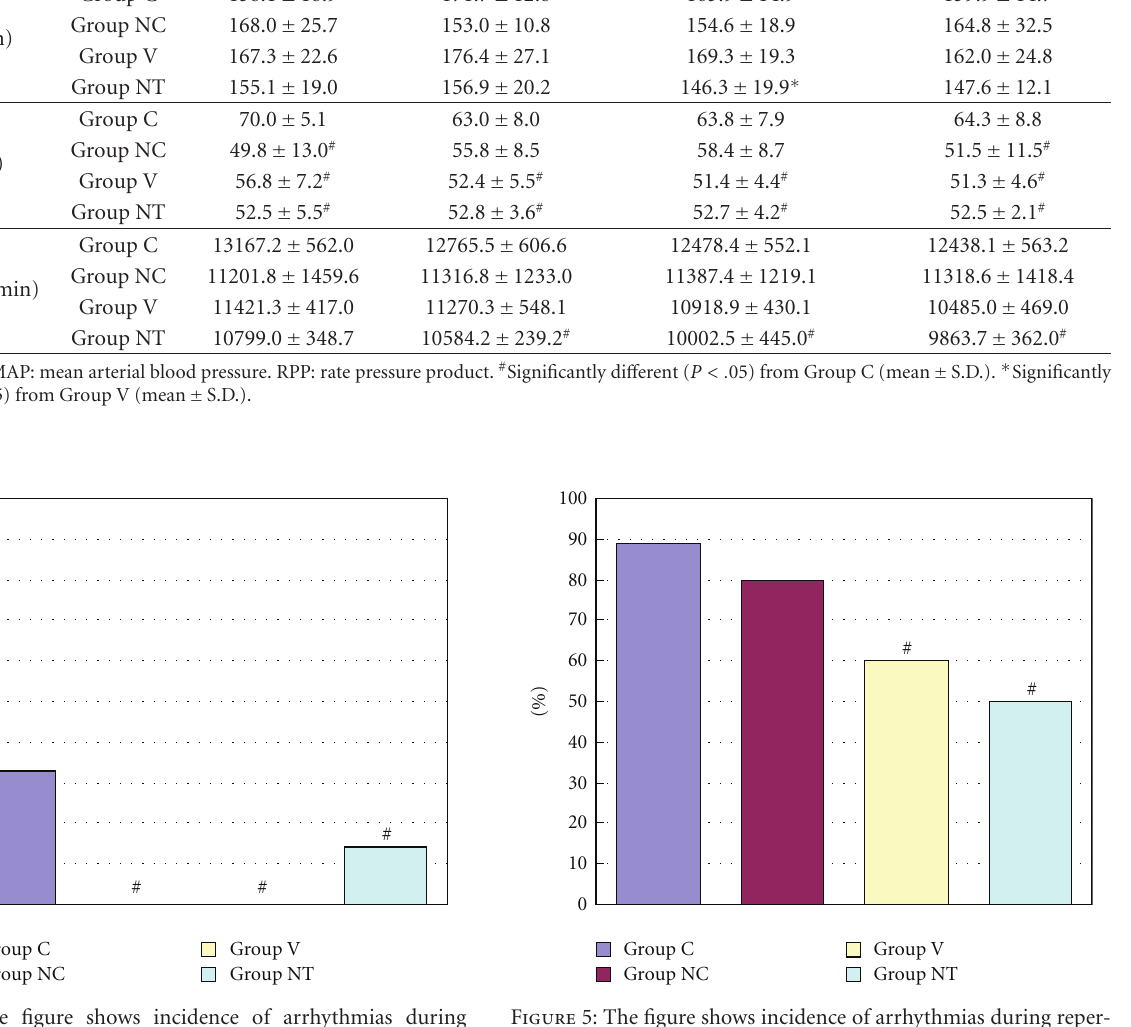
model as indexes of myocardial infarct size and duration of ventricular arrhythmias during ischemia and